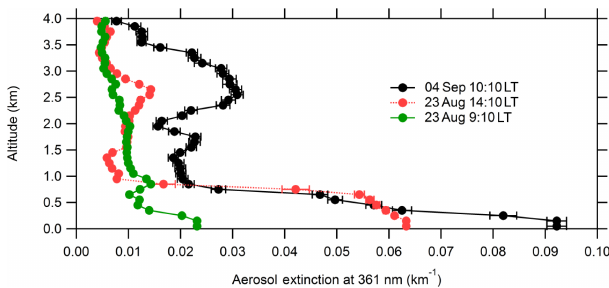
Figure 10. Examples of lidar vertical profiles of aerosol extinction (averaged into MAX-DOAS retrieval height intervals and times) on 23 August and 4